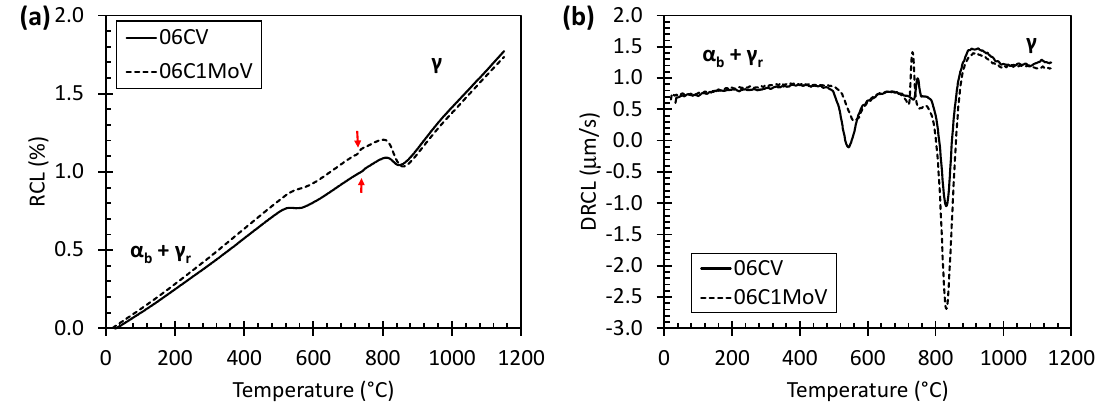
Figure 3. Dilatometry results of ( a ) relative change in length and ( b ) first derivate during a continuous heating up to austenitization temperature for all steels.